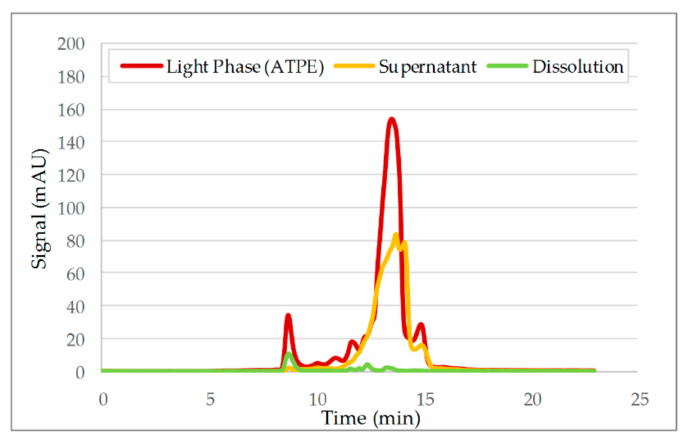
Figure 17. Recovery of mAb after precipitation. LP (light phase) from ATPE (aqueous two-phase extraction) was used as base material, including a washing step after loading the hollow fiber.